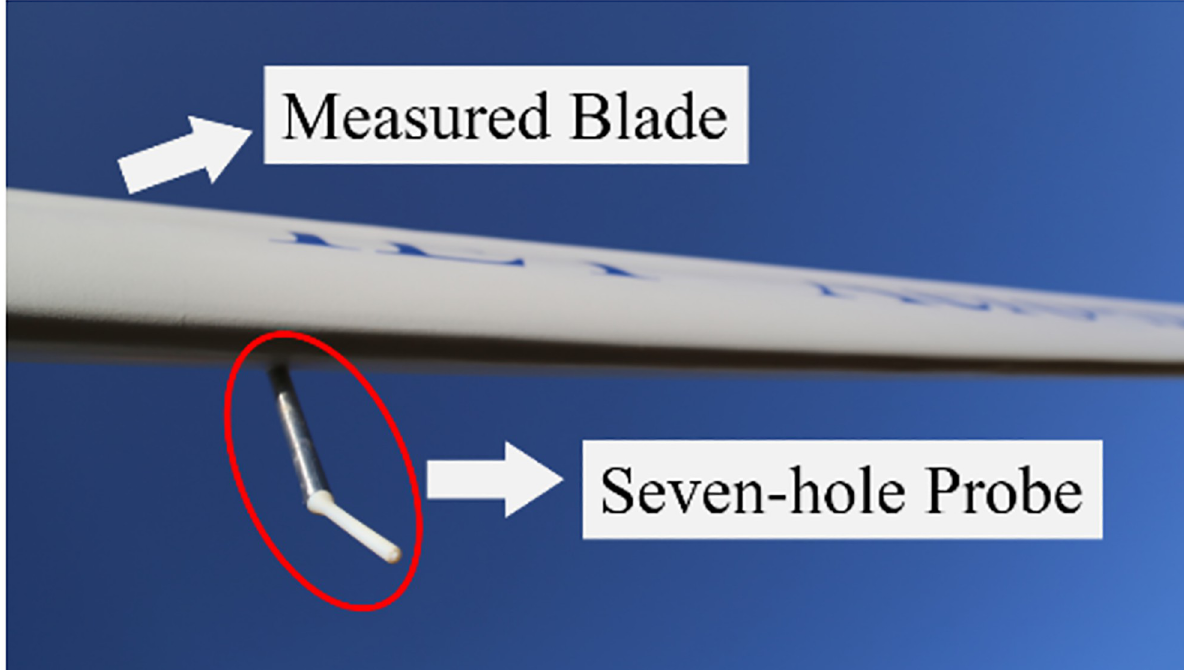
Fig 31. Photo of the probe mounted on the